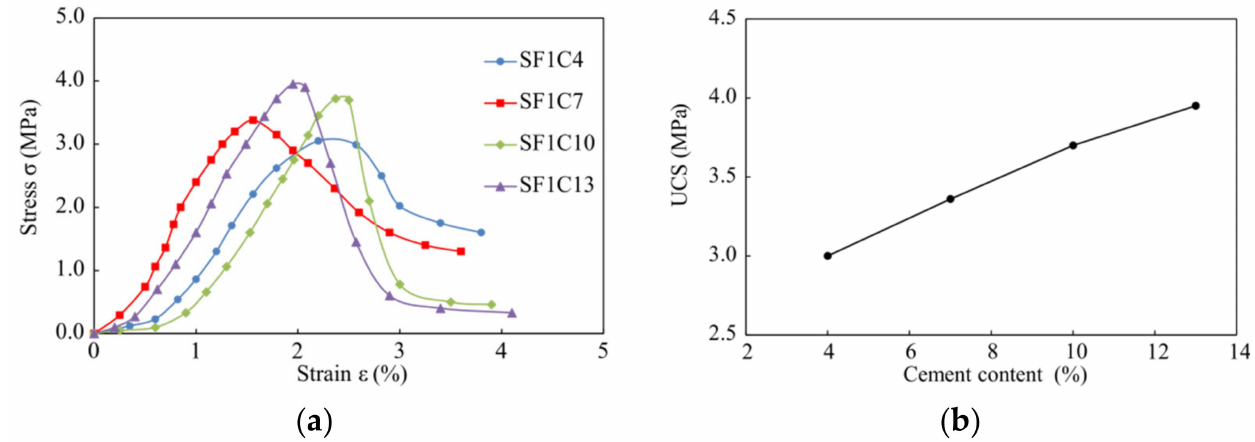
Figure 3. The UCT results for specimens with various cement contents: ( a ) stress–strain curves; ( b ) unconfined compression strength